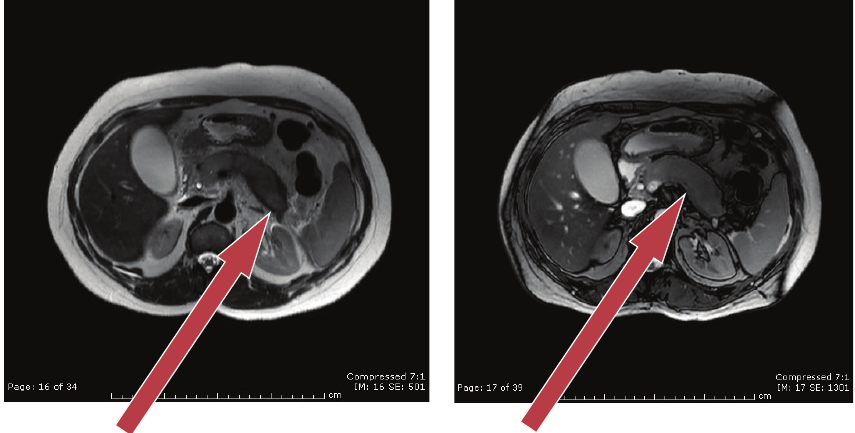
Figure 1: MRCP images arrow showing sausage-like pancreas in delayed